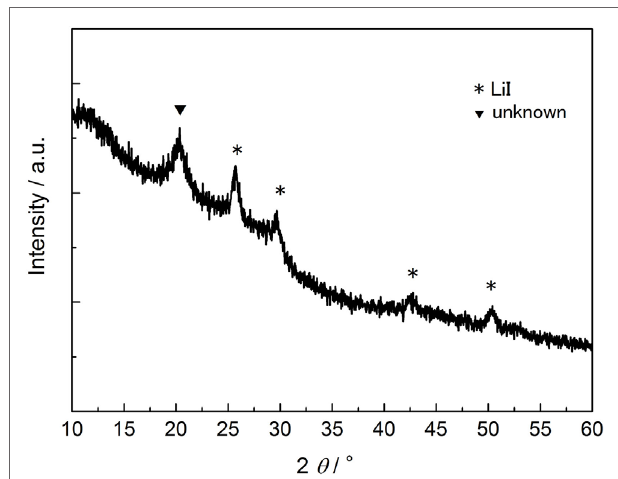
FigUre 2 | X-ray diffraction of lii-li 3 Ps 4 . *Peaks assigned in the reaction residue of LiI crystalline. Li 2 S was completely consumed by the reaction.